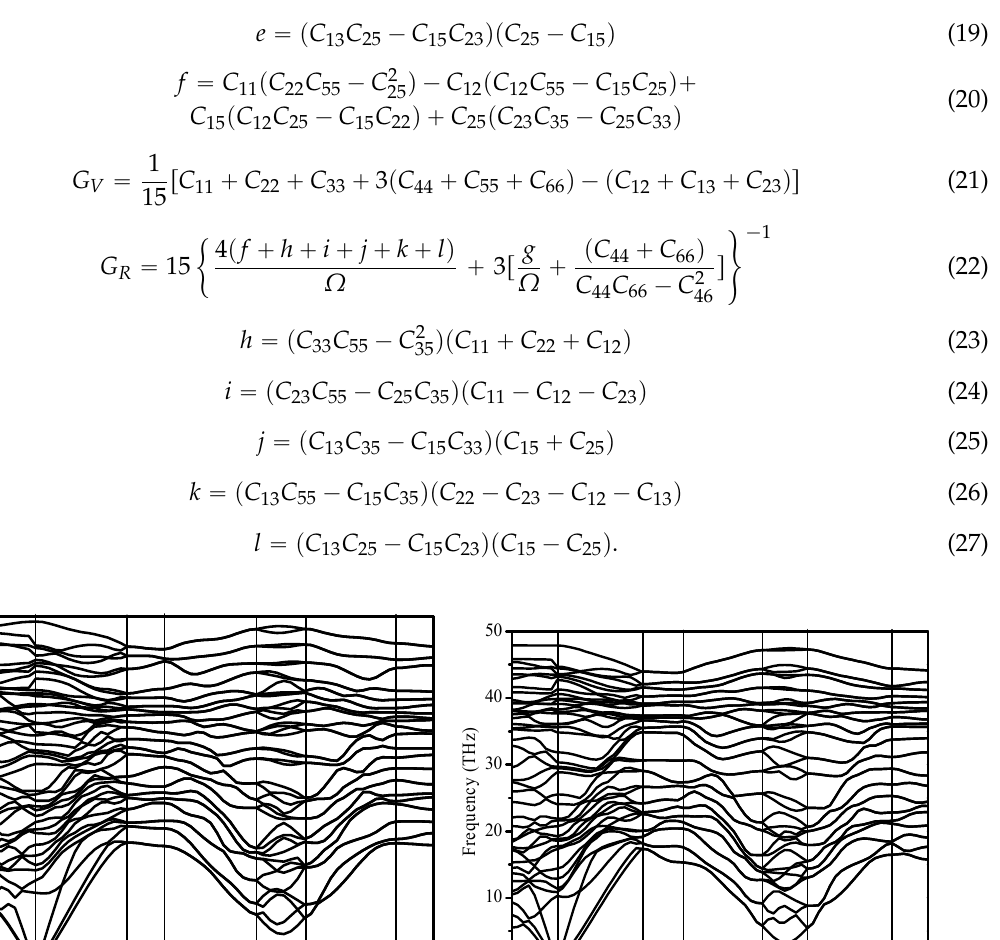
3 N 4 ( a , b ); and t -C 3 N 4 ( c , d